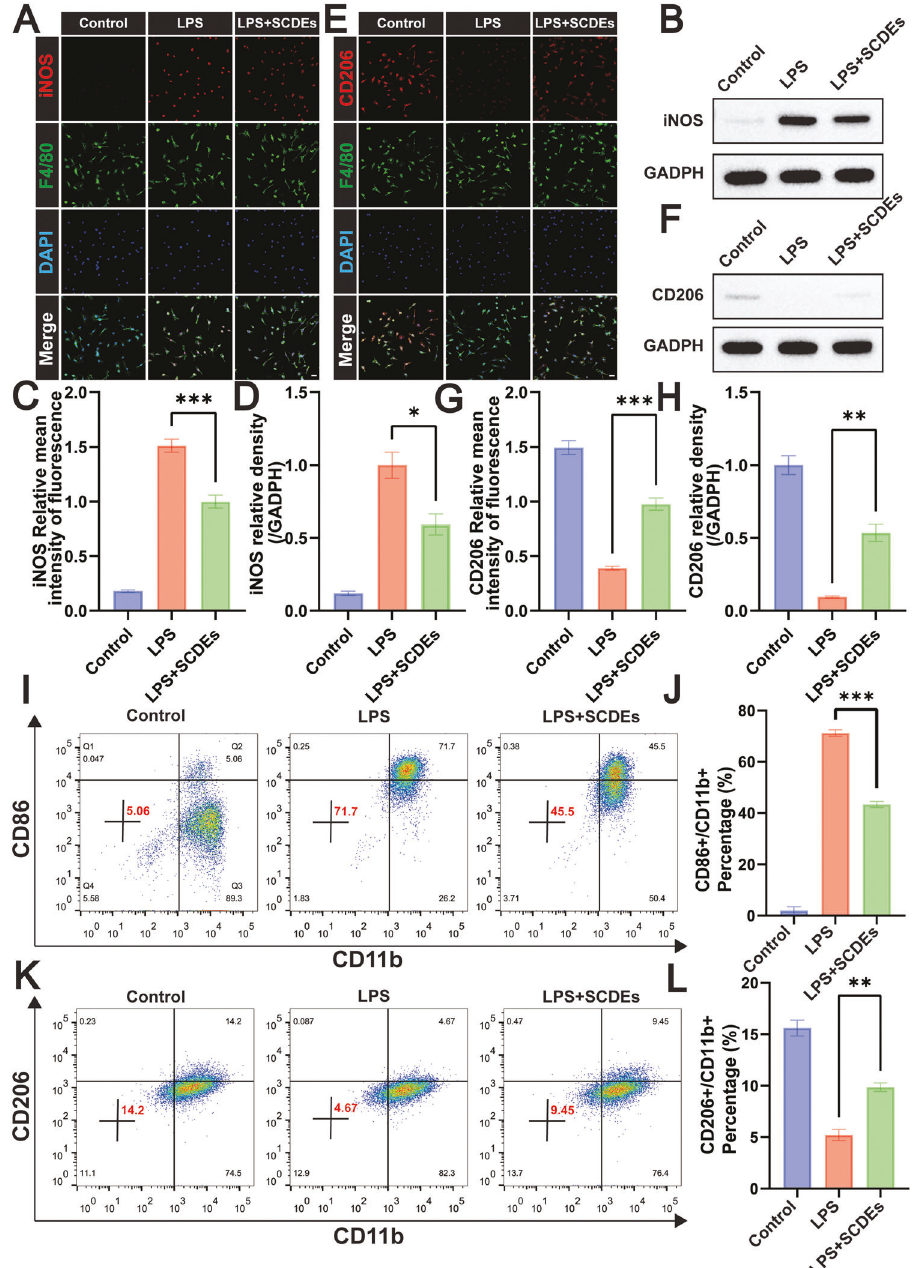
Fig. 2 The regulation of SCDEs on M1/M2 polarization in LPS-stimulated BMDMs. A Representative images of iNOS (red) and F4/80 (green). Nuclei were labeled with DAPI (blue). Scale bar: 20 μ m. B Representative western blots showing the reduction of iNOS. C The image analysis results were presented as the relative mean intensity of the fl uorescence of iNOS ( n = 5). D Quantitative analysis of the iNOS/GAPDH ratio ( n = 3). E Representative images of CD206 (red) and F4/80 (green). Nuclei were labeled with DAPI (blue) in each group ( n = 5). Scale bar: 20 μ m. F Representative western blots showing the increase of CD206. G The image analysis results were presented as the relative mean intensity of the fl uorescence of CD206 ( n = 5). H Quantitative analysis of the CD206/GAPDH ratio ( n = 3). I – J Flow cytometry assay detected CD86 + M1 phenotype, indicating that SCDEs treatment suppressed the M1 polarization in LPS-stimulated BMDMs ( n = 3). K , L Flow cytometry assay detected CD206 + M2 phenotype, showing that SCDEs treatment promoted the M2 polarization in LPS-stimulated BMDMs ( n = 3). Data were presented as mean ± SEM. Results were analyzed by One-way ANOVA. Signi fi cance: * P < 0.05, ** P < 0.01, *** P <